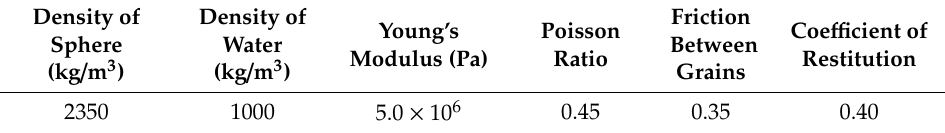
Table 1. Parameters for numerical